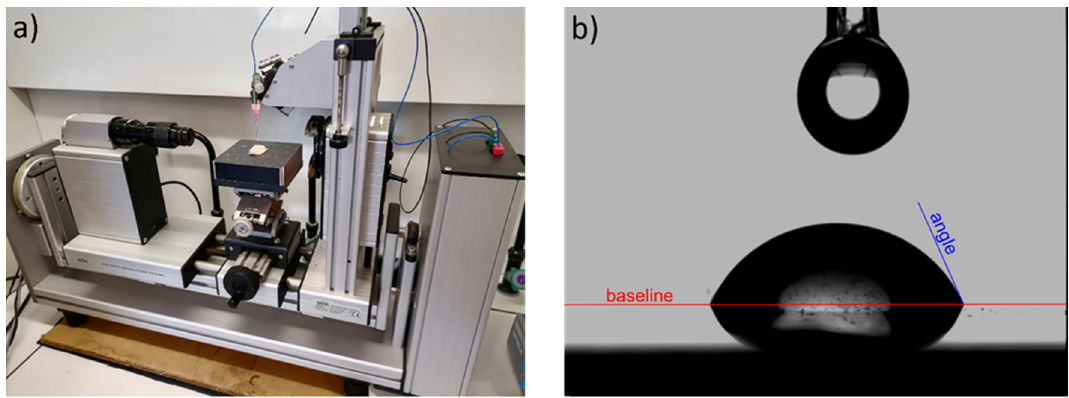
Figure 7. ( a ) Drop shape analysis profile (DSA-P) device from Kruss™. ( b ) Example of picture used to measure the contact angle on a surface through a dedicated software.